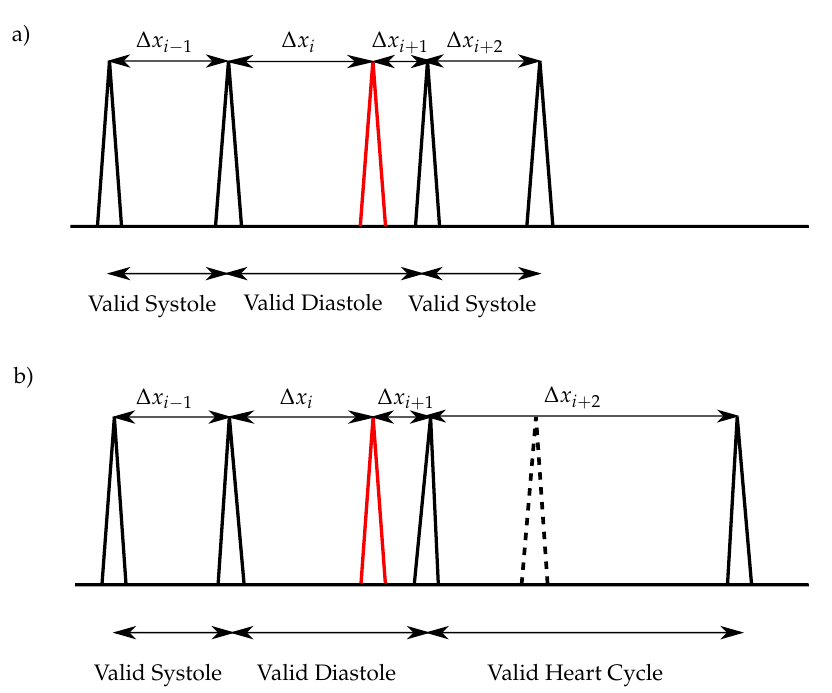
Figure 8. Heart sound classification for normal heart rates: ( a ) One extra sound (red), which is near to an S 1 , exists within the diastole and no S 2 is missing; ( b ) One extra sound (red), which is near to an S 1 , exists within the diastole and one S 2 is missing (dashed